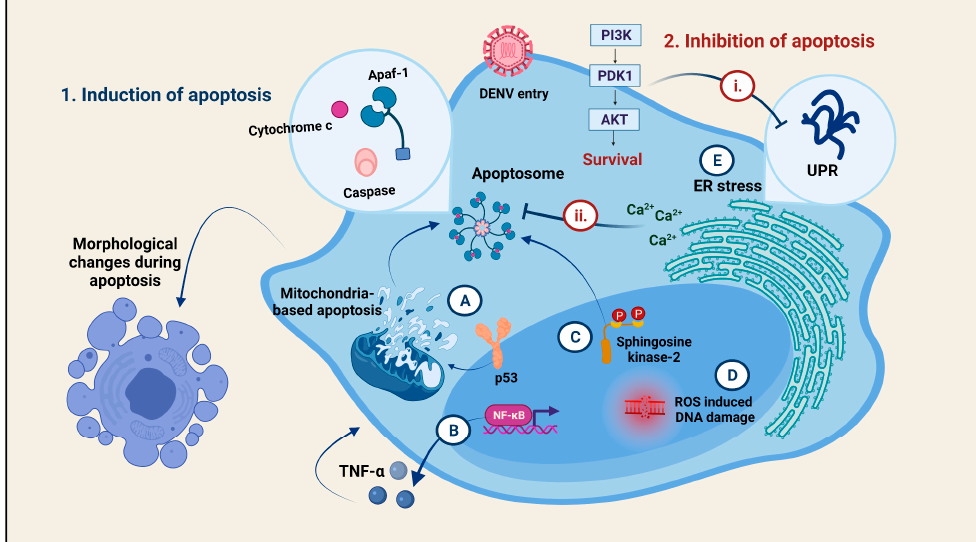
Figure 5. Regulation of cell death via apoptosis during Dengue virus infection: The Dengue virus is capable of 1. Inducing apoptosis as well as 2. Inhibiting apoptosis in target cells, depending upon its requirement. The different mechanisms of apoptosis induction are: A. Induction of the mitochondria-based apoptosis by the pro-survival protein, p53, to assemble the apoptosome for Caspase-3, 9 activation. B. The NF κ B-TNF- α mediated induction of cell apoptosis. C. The Sphingosine-kinase-2 mediated induction of apoptosome formation. D. ROS-induced DNA damage that ultimately leads to the death of the cell. E. Induction of ER stress to activate the UPR responses in the ER of the cell. All these mechanisms result in morphological changes in the cell indicative of apoptosis-mediated cell death. The DENV also allows the survival of the cell so as to continue parasitizing it. The anti-apoptotic mechanisms include: i. Increased Akt phosphorylation to inhibit the ER-stress-induced UPR responses in the cell and ii. Enrichment of cytoplasmic calcium ions to inhibit the apoptosome